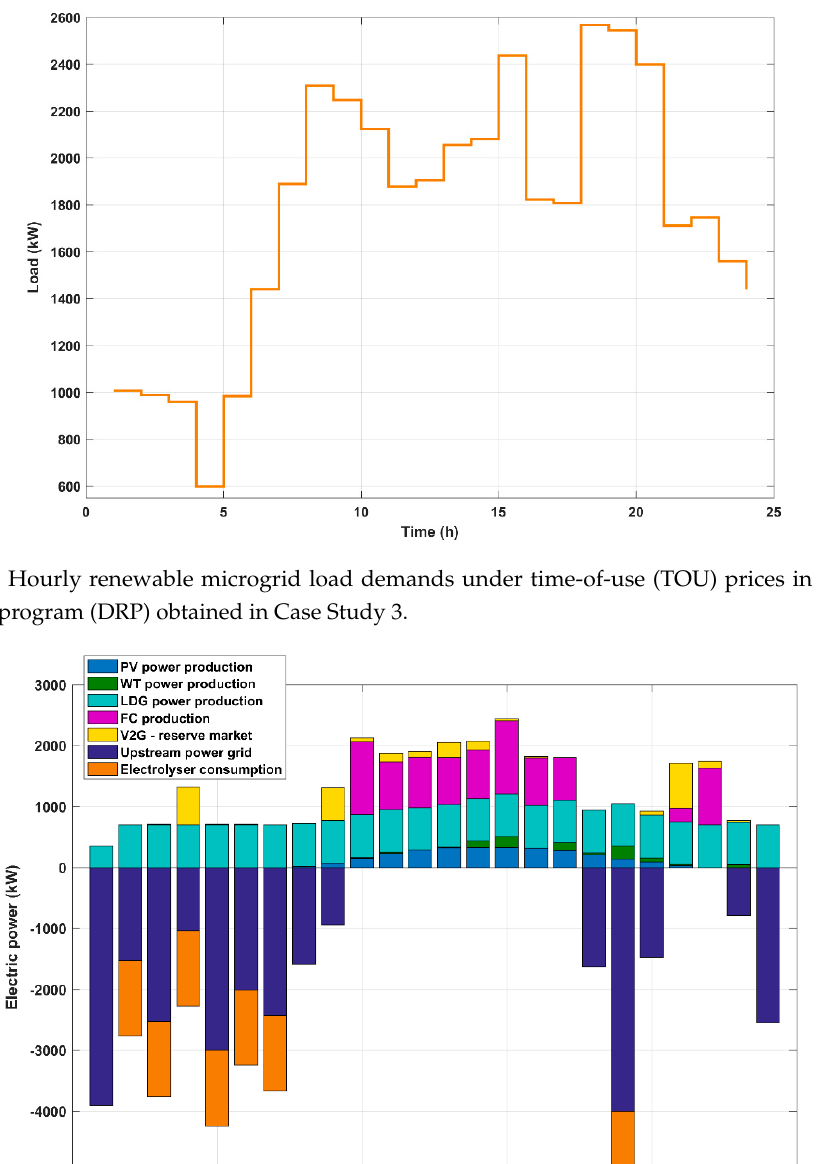
Figure 9. Optimal electric power dispatching results obtained in Case Study 3.